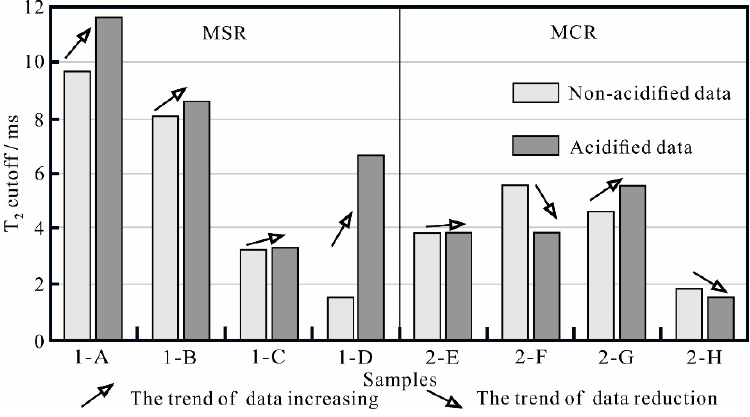
Figure 17. The T 2 cutoff value of the selected samples calculated by centrifugation before and after acidification.